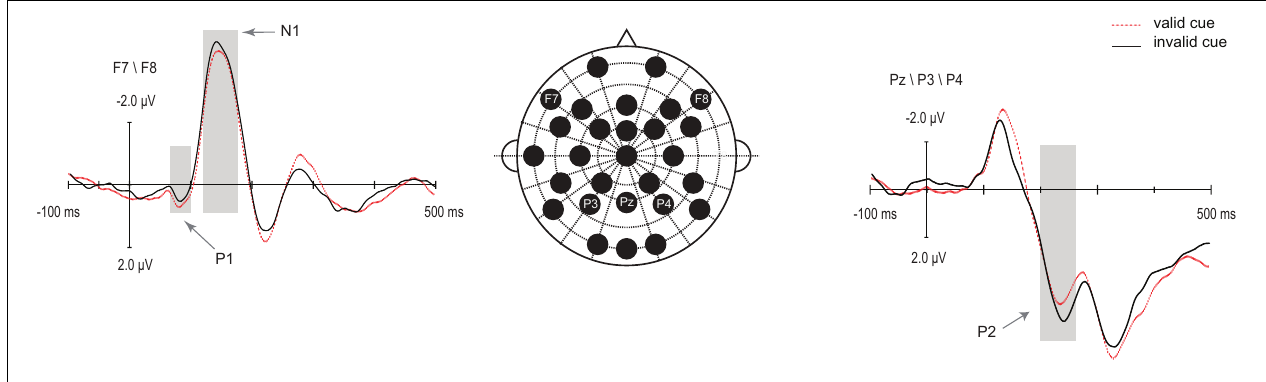
FIGURE 2 | Grand average ERPs from audiovisual stimuli in valid cue (red dotted line) and invalid cue (black solid line) conditions on the analyzed